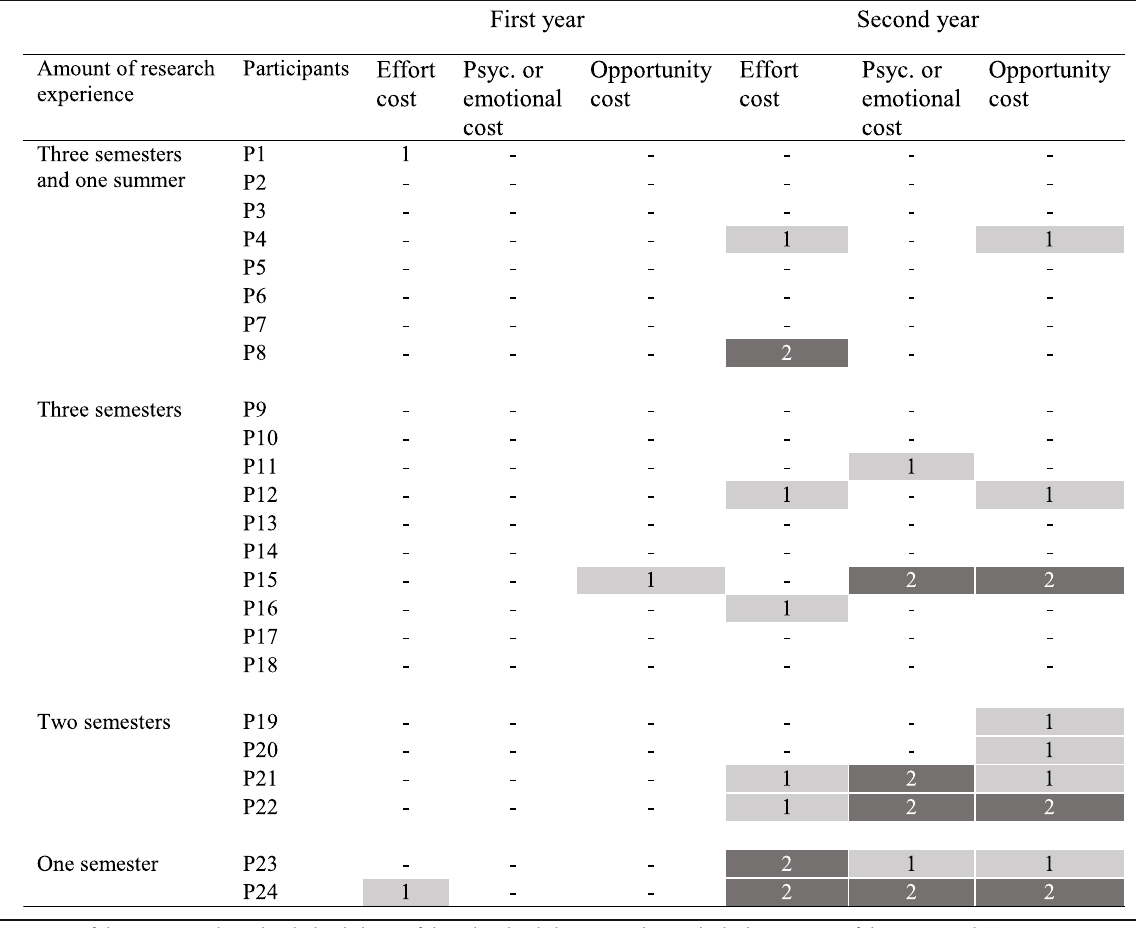
Table 6 Weight given to types of costs associated with the research